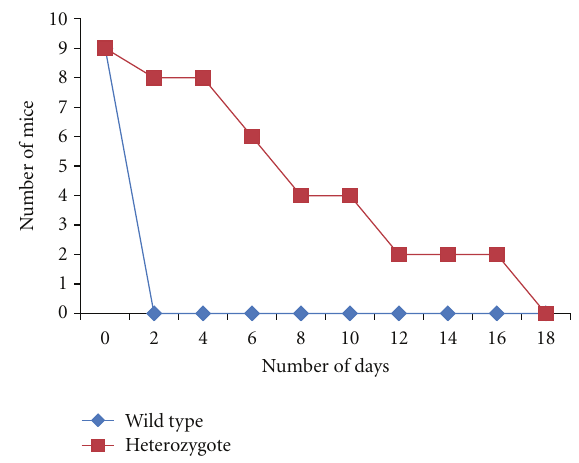
Figure 4: Disseminated model of candidiasis. BALB/c mice were injected in their tail vein with 5 × 10 6 C. albicans cells, and survival was monitored daily. Survival analysis was based on the Kaplan Meier method and the log Rank test. As can be seen, the mutant strain is significantly defective in virulence when compared to the wild type ( P = . 001).